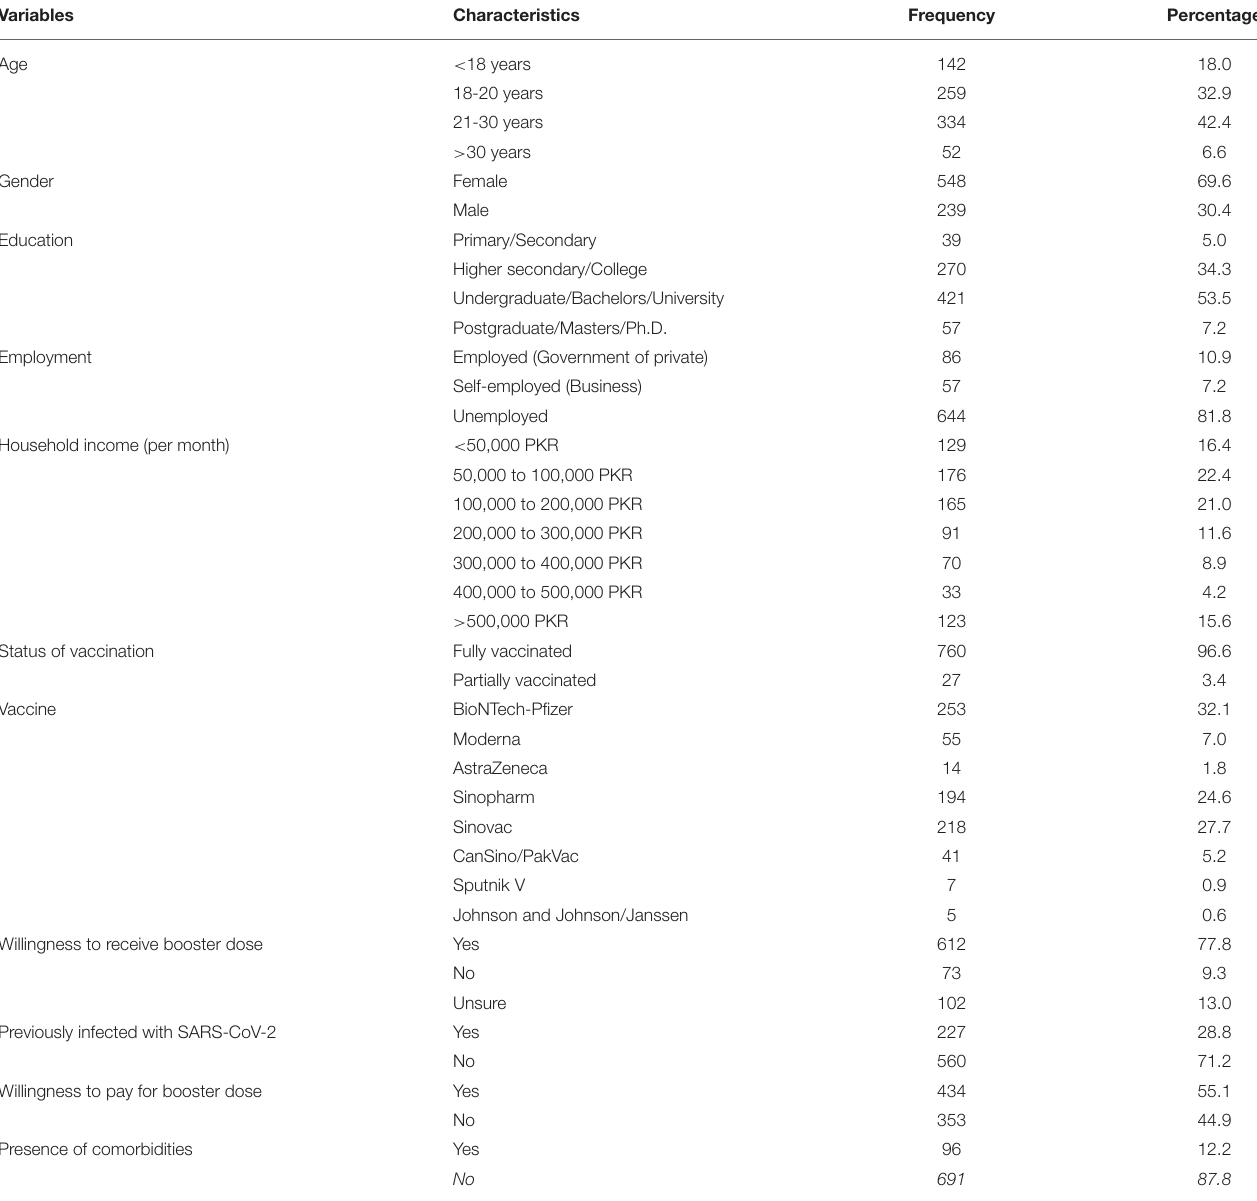
TABLE 1 | General and demographic characteristics of the study population ( n = 787).